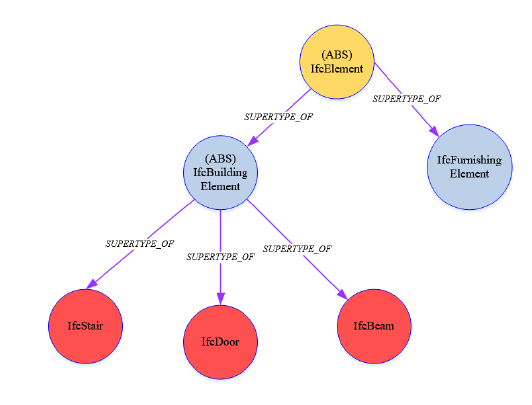
Figure 5. IFC IMG diagram